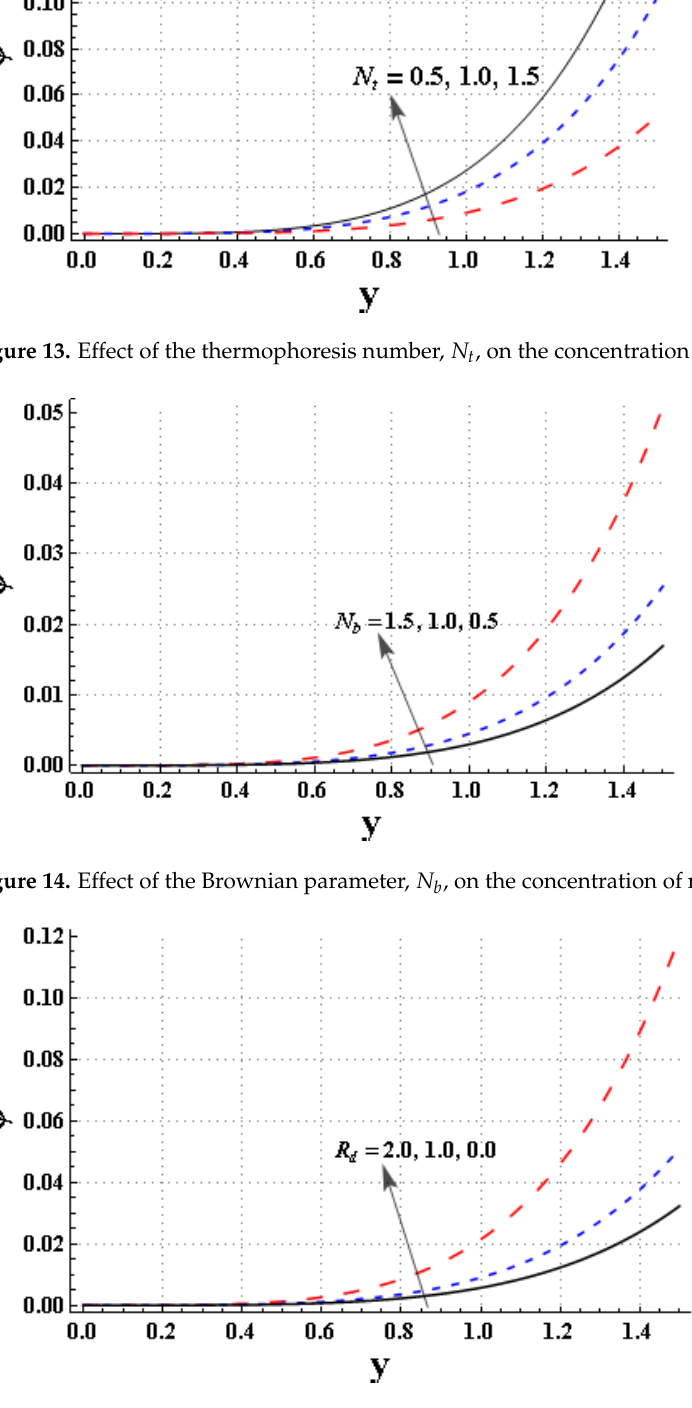
Figure 15. Effect of R d , on the concentration of nanomaterials, ϕ